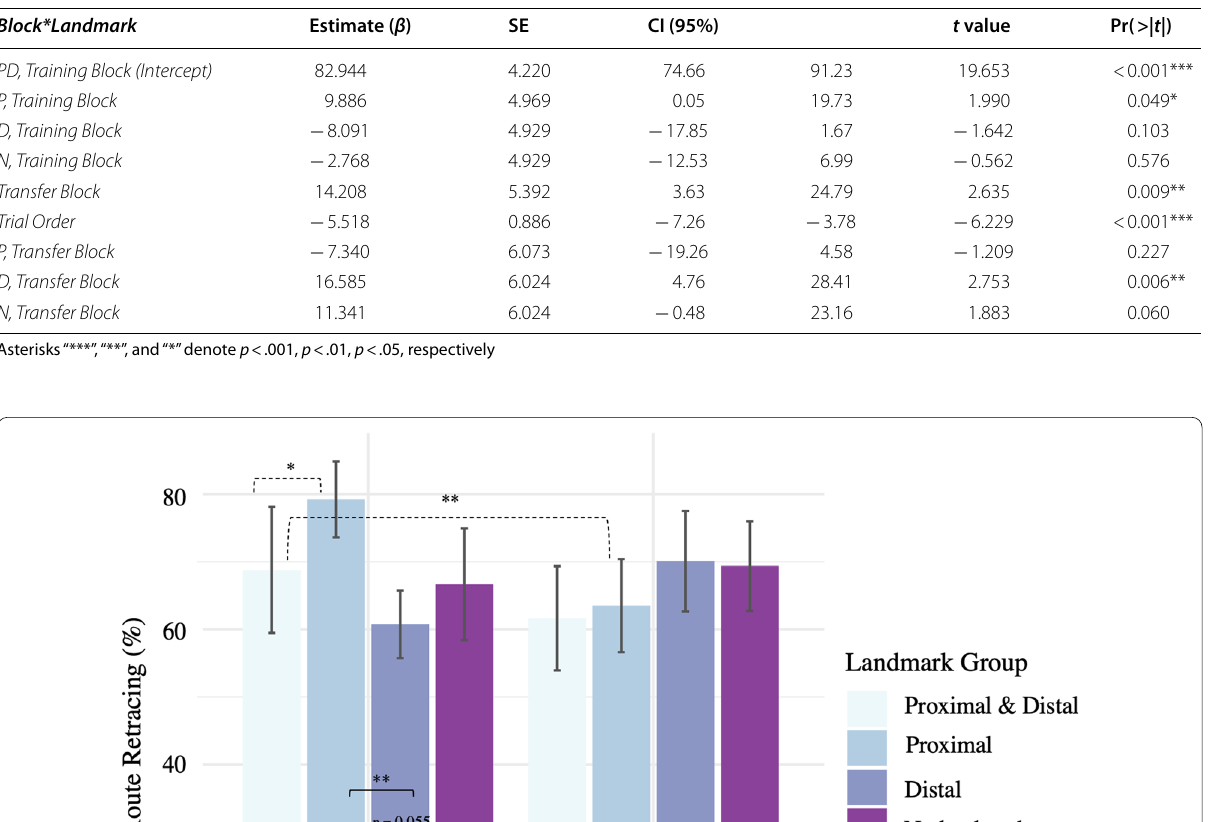
Table 2 Results of the linear mixed model with route retracing modelled by Landmark group (PD, P, D & N) and Block (Training & Transfer)